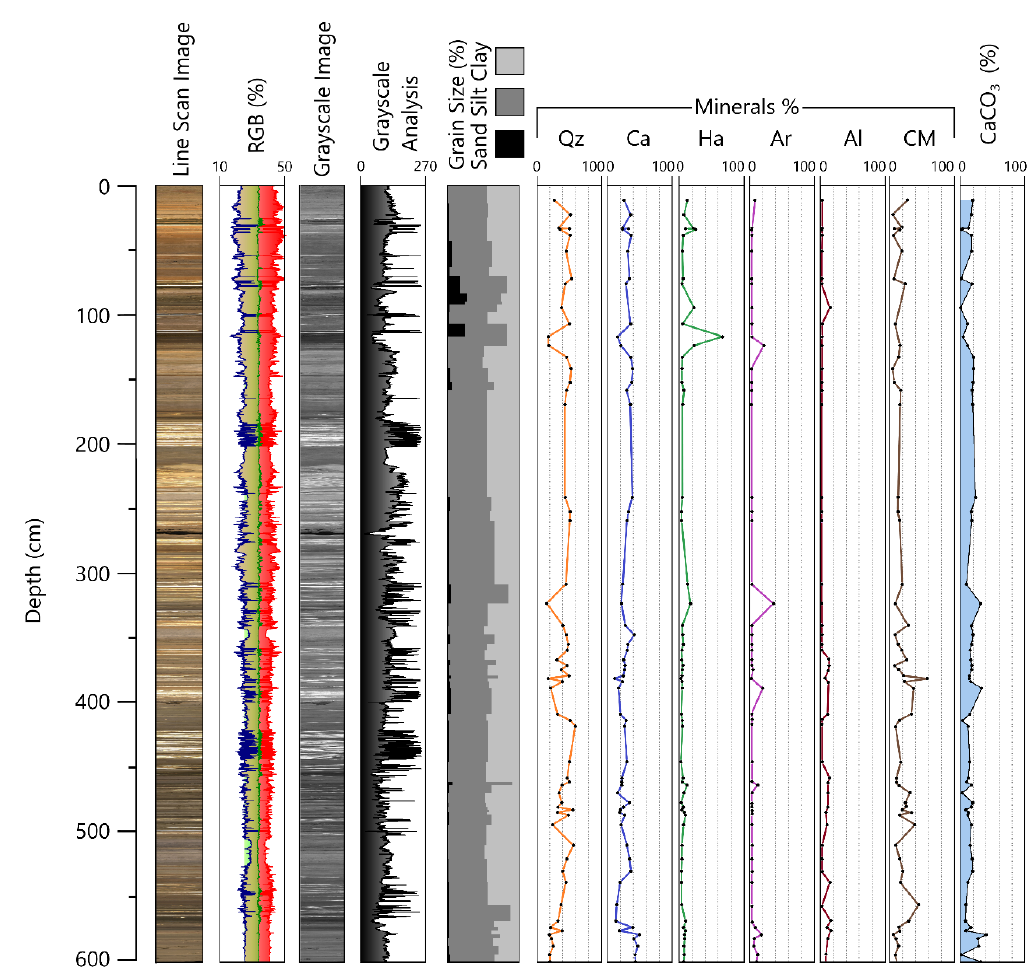
Figure 2. Log profile of Vouliagmeni core presenting (from left to right): Line scan image of the core, RGB (%) profile, 8-bit grayscale image, grayscale analysis values, grain size distribution, mineralogical composition (%) (Qz: quartz, Ca: calcite, Ha: halite, Ar: aragonite, Al: albite, CM: clay minerals) and CaCO 3 content.